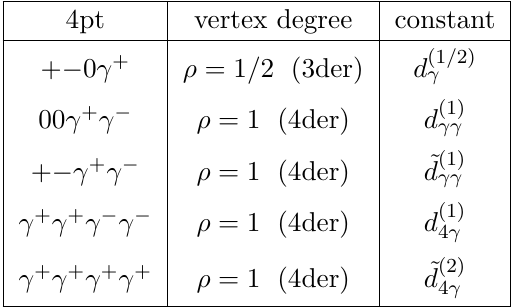
Table 3 . List of possible 4pt vertices of a scalar triplet and a